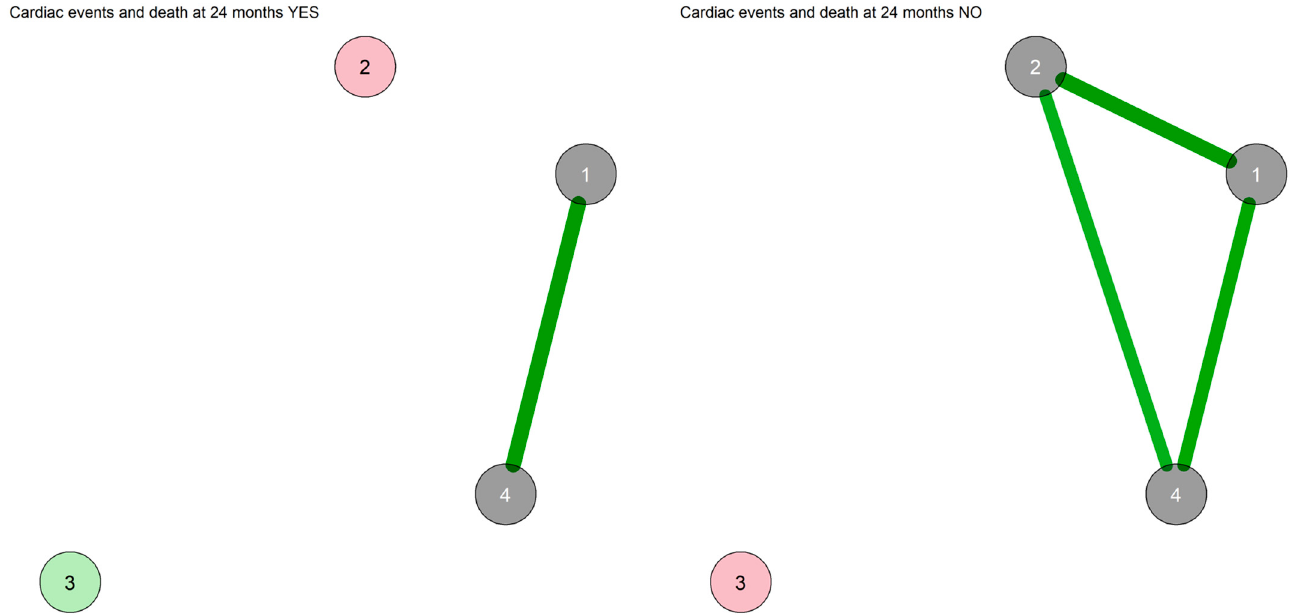
Figure 4. Network of symptoms with Bayesian estimation and walktrap community detection in the subgroups with and without MACE at 24 months. 1: Depression; 2: Somatic; 3: Agitation; 4: Anxiety. Each node corresponds to a symptom cluster identified in the previous symptom reduction. Nodes are connected with lines (edges) that represent the strengths of associations between nodes. Green edges suggest positive associations, whereas red edges suggest negative associations. The thickness of the edge represents the edge’s weight, which is an indication of the strength of the association. The thicker the edge, the greater the weight and the stronger the association. In this network, all edges connecting the nodes are green (positive correlation), and their widths indicate the strength of their connections. Node colors indicate the community of the nodes. In the MACE YES network, three communities were identified: somatic symptoms, depression and anxiety, and agitation. In the MACE NO network, two communities were identified: pink for agitation, and grey for somatic symptoms, depression and anxiety. All edges connecting the nodes are green (positive correlation), and their widths indicate the strength of their